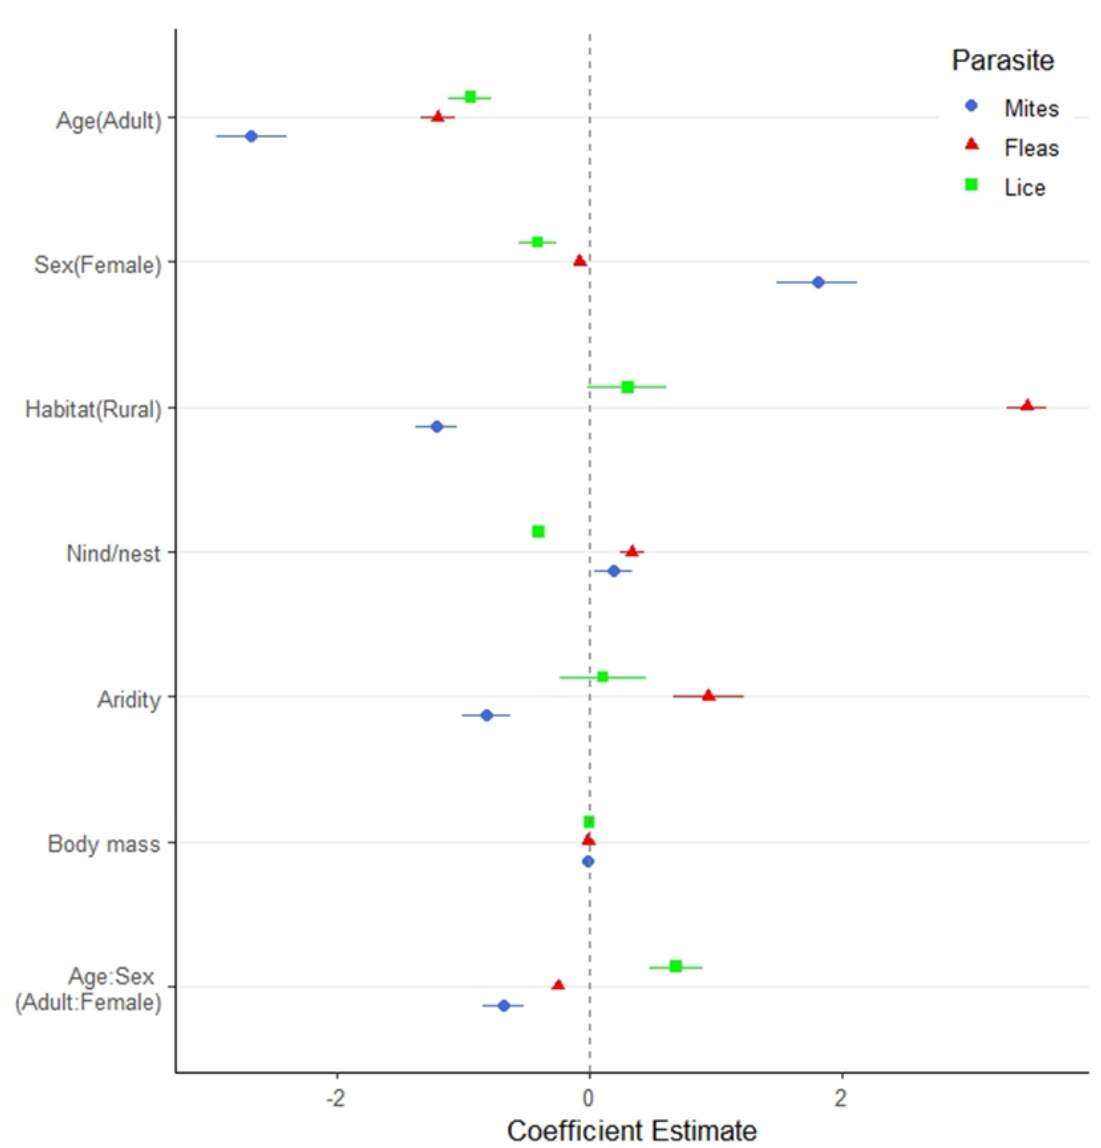
Figure 2. Influence of individual traits (sex, age, body mass), and environmental conditions (number of conspecifics per burrow, habitat type, and the aridity of the area) on the abundance of mites, fleas and lice in the burrowing owls Athene cunicularia . Estimated coefficients (and 95% confidence intervals) of the covariates for the three ectoparasite groups. 95% confidence intervals overlapping 0 (dashed vertical line) indicate a non-significant coefficient.